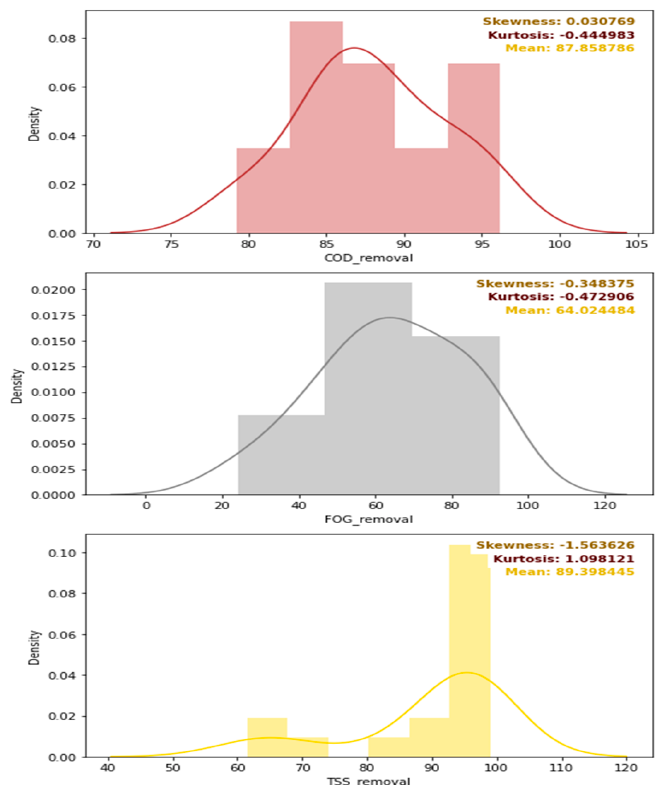
Figure 22. Density distribution, skewness, kurtosis, and mean values of the removal efficiencies of the MBR after DEGBR treatment.